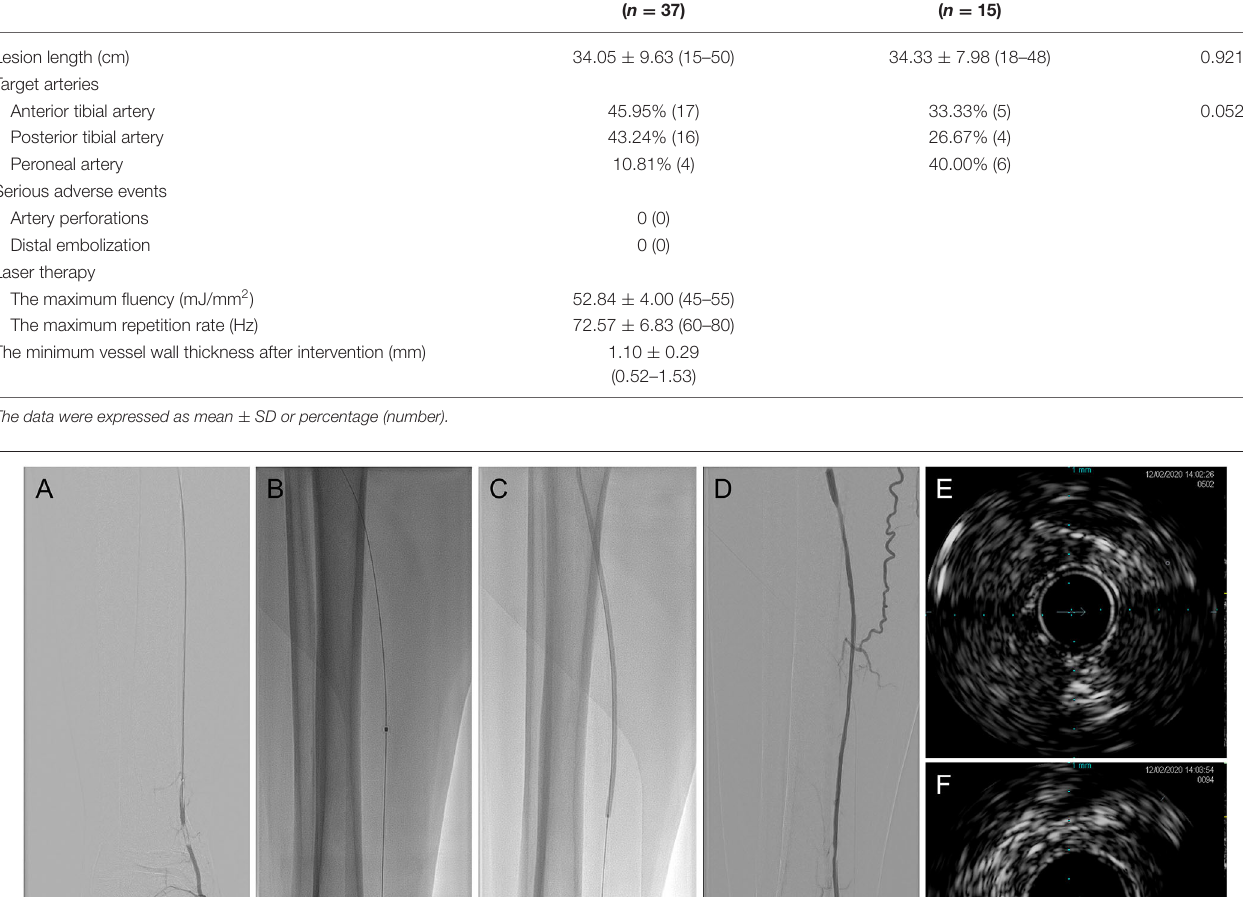
TABLE 2 | The procedural data of laser-assisted angioplasty. Variable